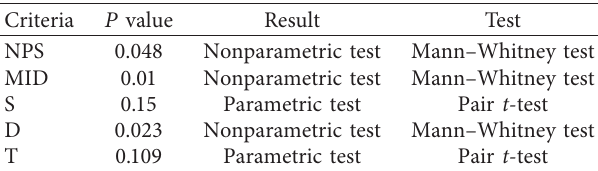
Table 5: The results of normality test for evaluation